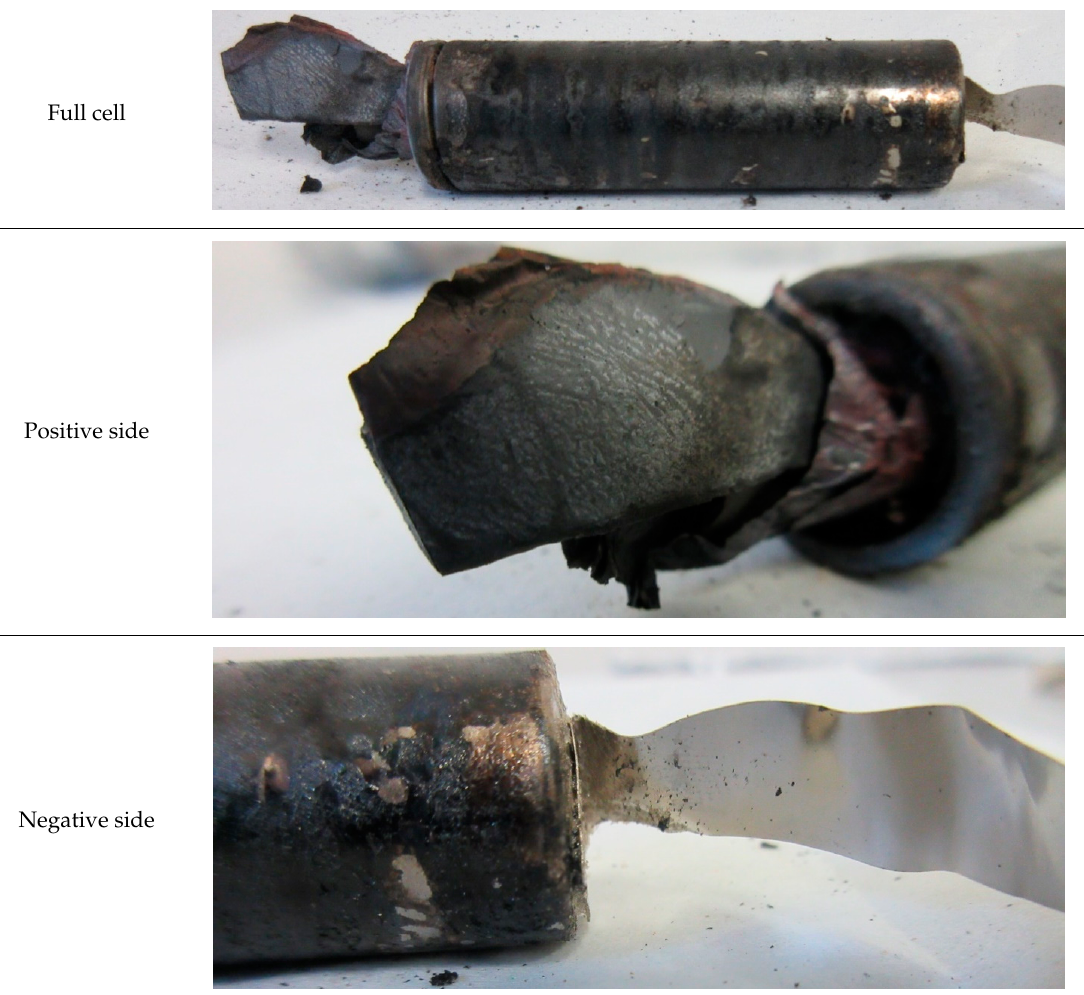
Table A2. Thermally abused LG HG2 at 50% SOC.